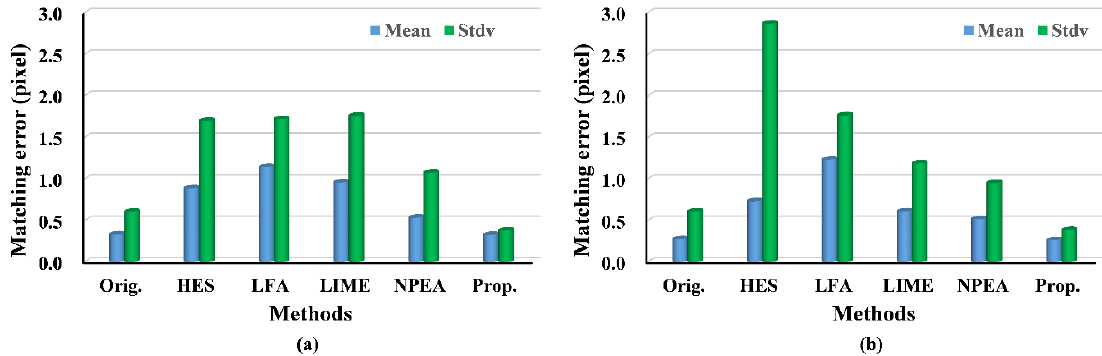
Figure 8. Histograms of matching error using SIFT: ( a ) the fourth image pair; ( b ) the fifth image pair.